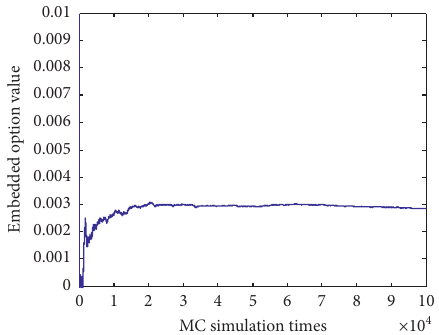
Figure 10: Simulation results of embedded option value in 10-year